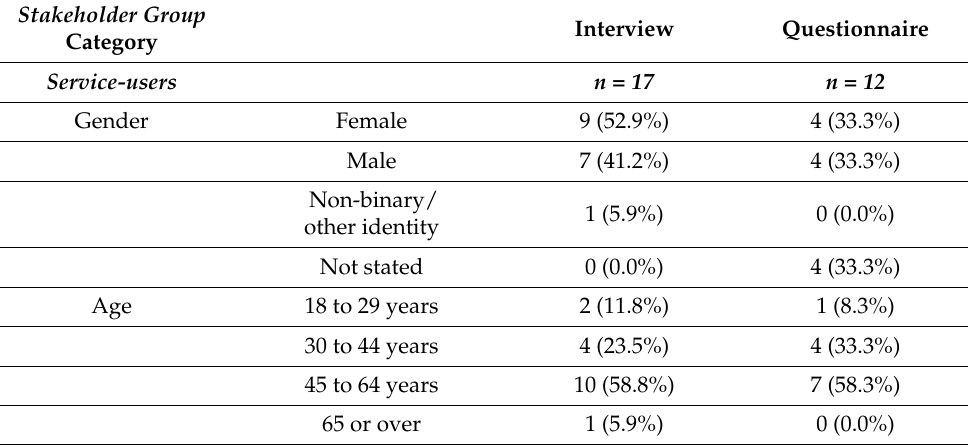
Table 1. Demographic summary of